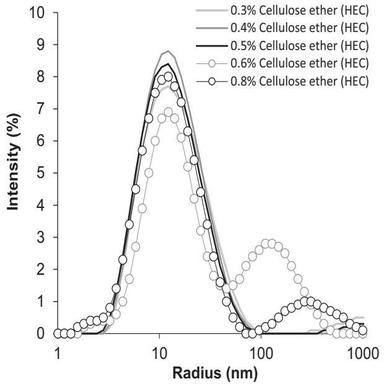
Relative contribution to the scattering light intensity as a function of the hydrodynamic diameter for Cellulose ether (HEC) in cement pore solution. Reproduced from.